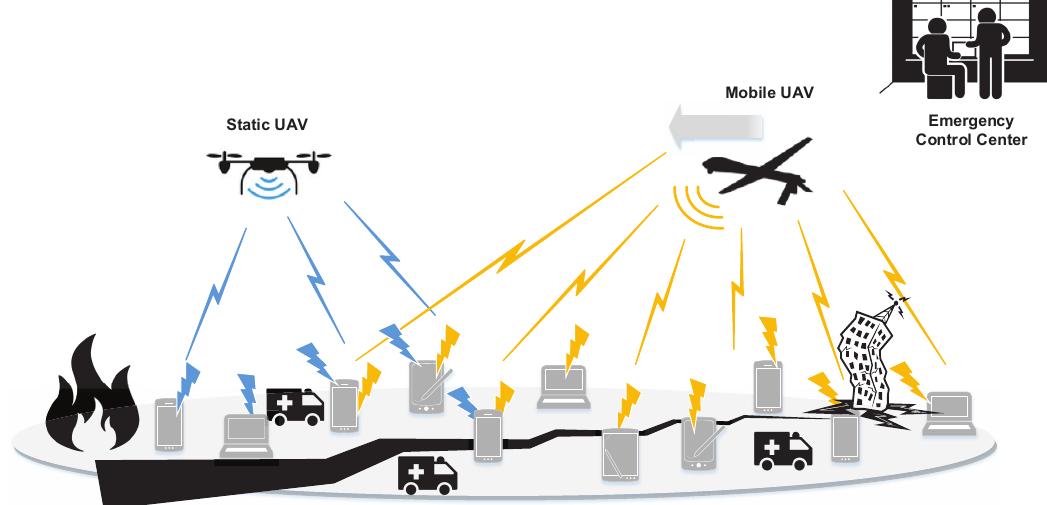
Figure 1. UAV-assisted public safety network